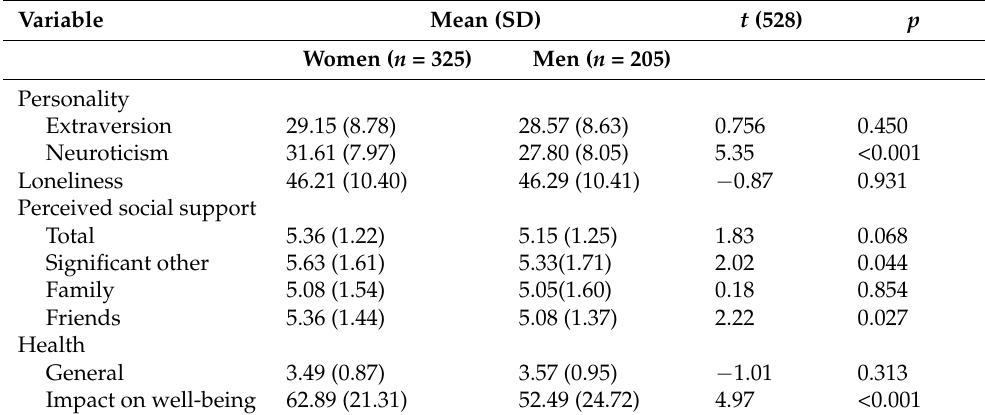
Table 2. Descriptive data for psychosocial and health outcome variables by gender.